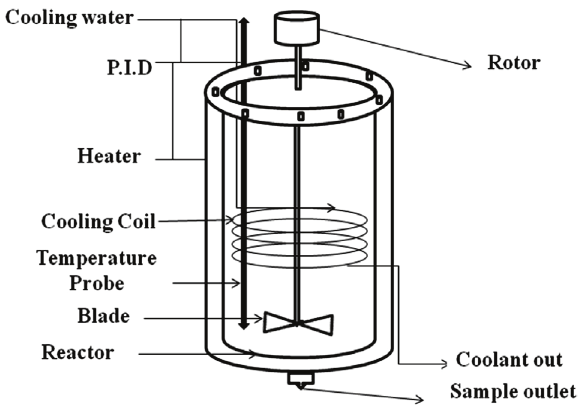
Fig. 1 – Schematic of the batch